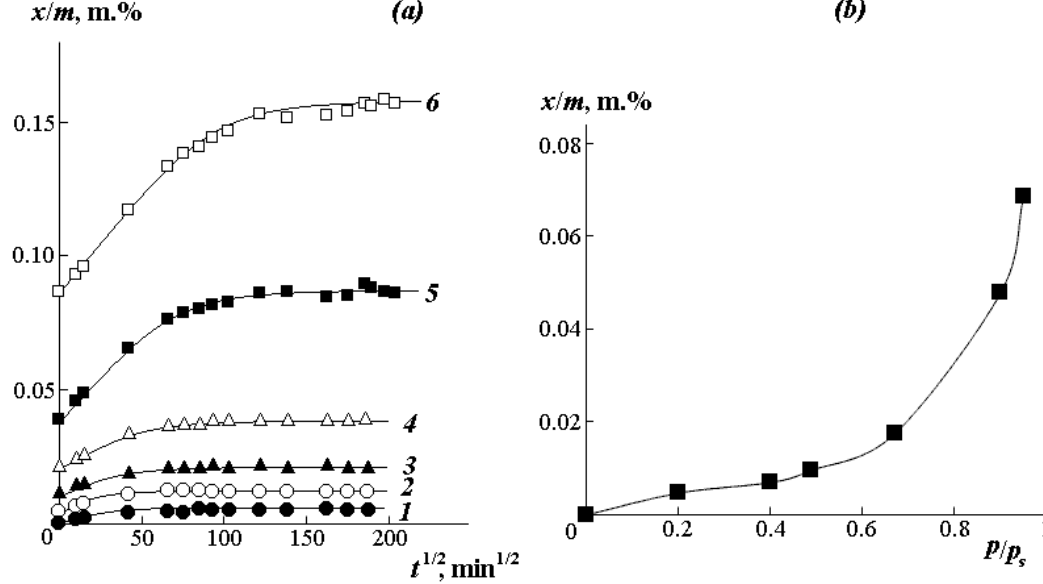
Figure 5. ( a ) Kinetic curves of interval sorption and ( b ) isotherms of water vapor sorption by PVME at 25 °C for vapor activity p / p s 0.2 (1), 0.4 (2), 0.49 (3), 0.67 (4), 0.9 (5), and 0.95 (6).